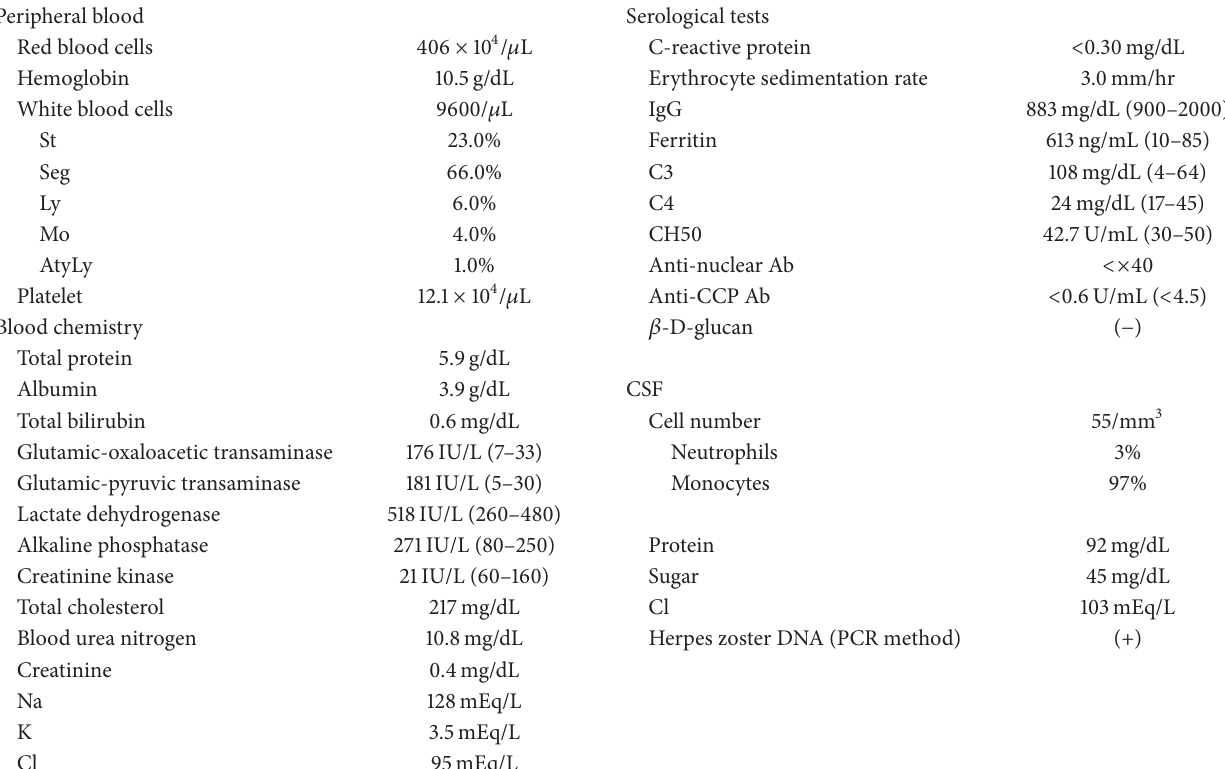
Table 1: Laboratory